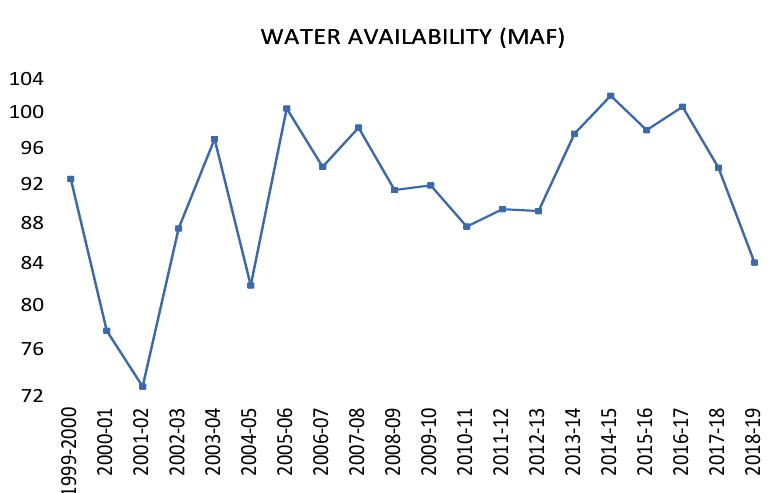
Figure 5: Water availability (million acre